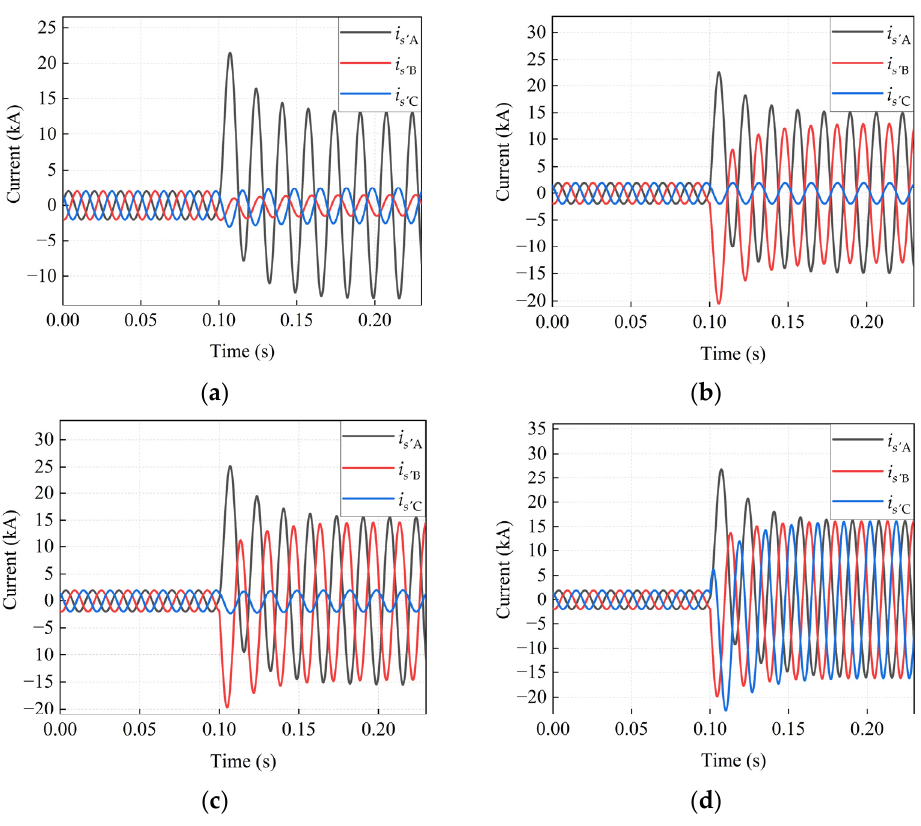
Figure 10. Three-phase fault currents of series windings for ( a ) single-phase-to-ground fault, ( b ) interphase fault, ( c ) two-phase-to-ground fault, and ( d ) three-phase-to-ground fault.